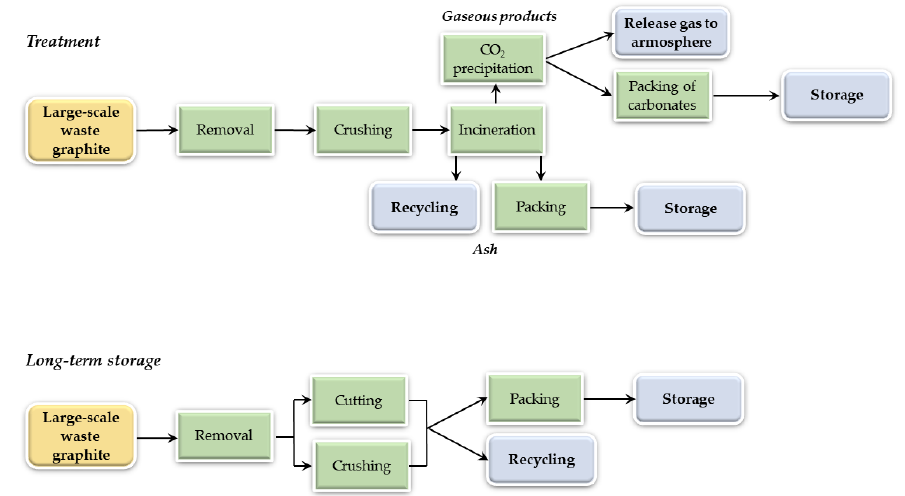
Figure 5. Long-term storage and treatment of graphite-containing waste; based on